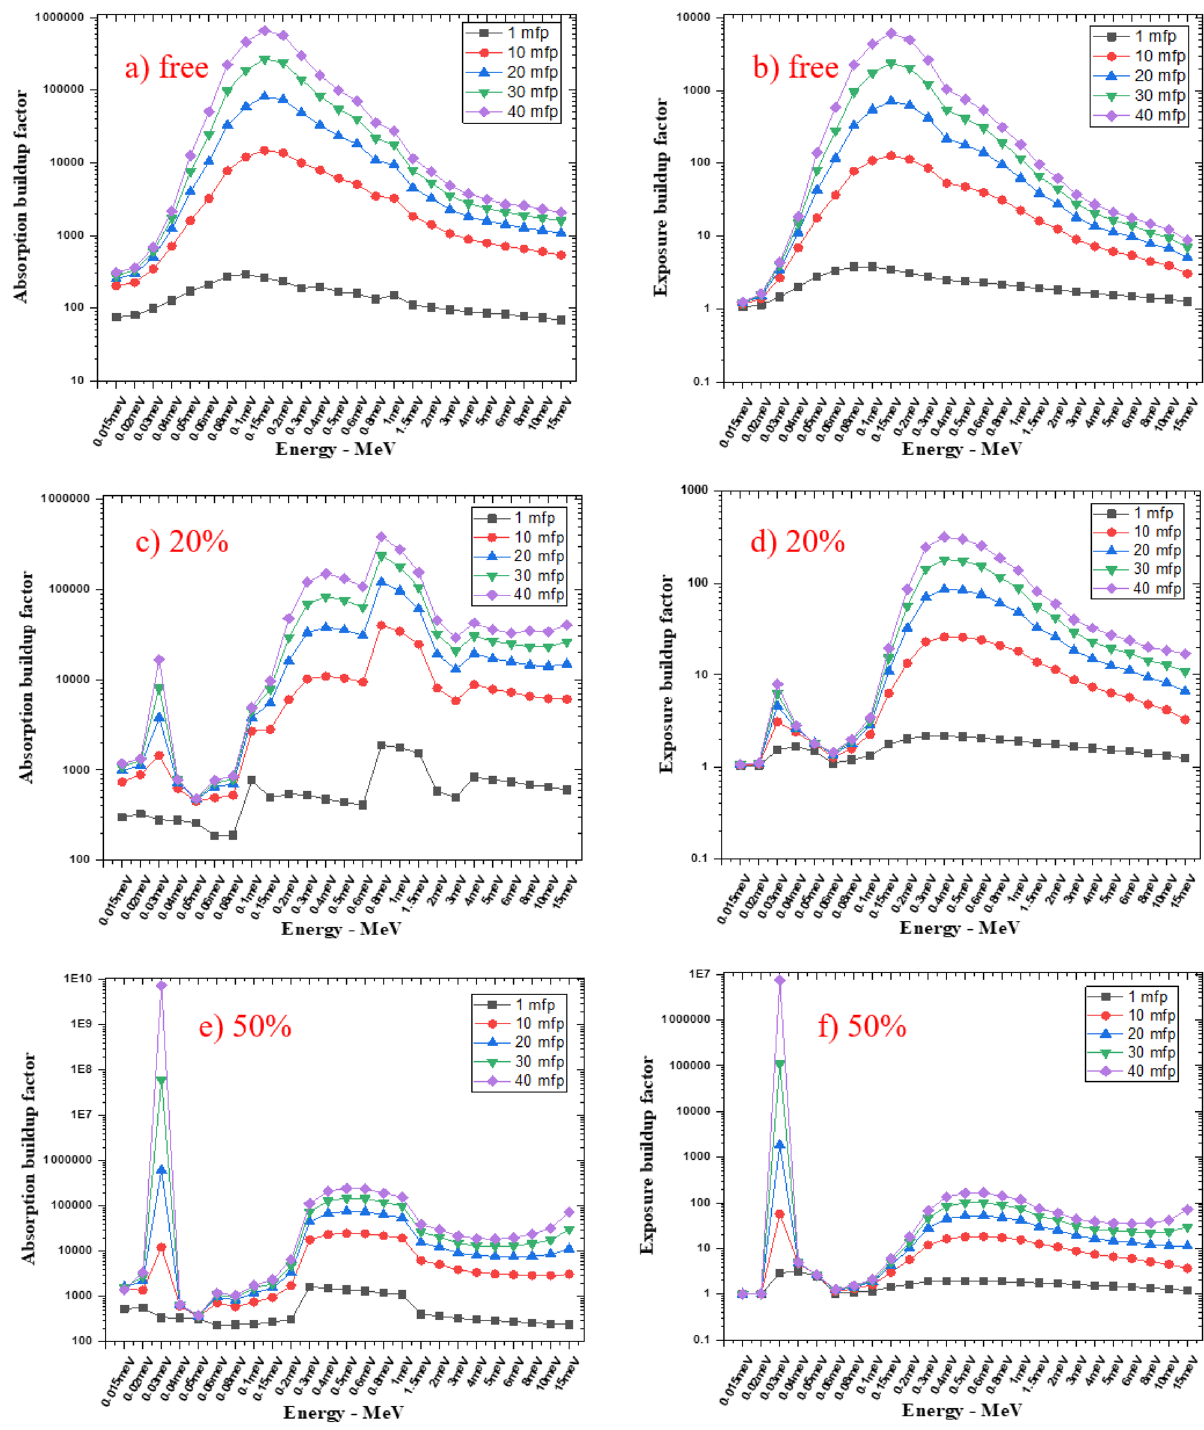
Figure 12. The absorption and exposure buildup factors of free silicon rubber, 20% SnO 2 /SR, and 50% SnO 2 /SR for different energies at 1, 10, 20, 30, and